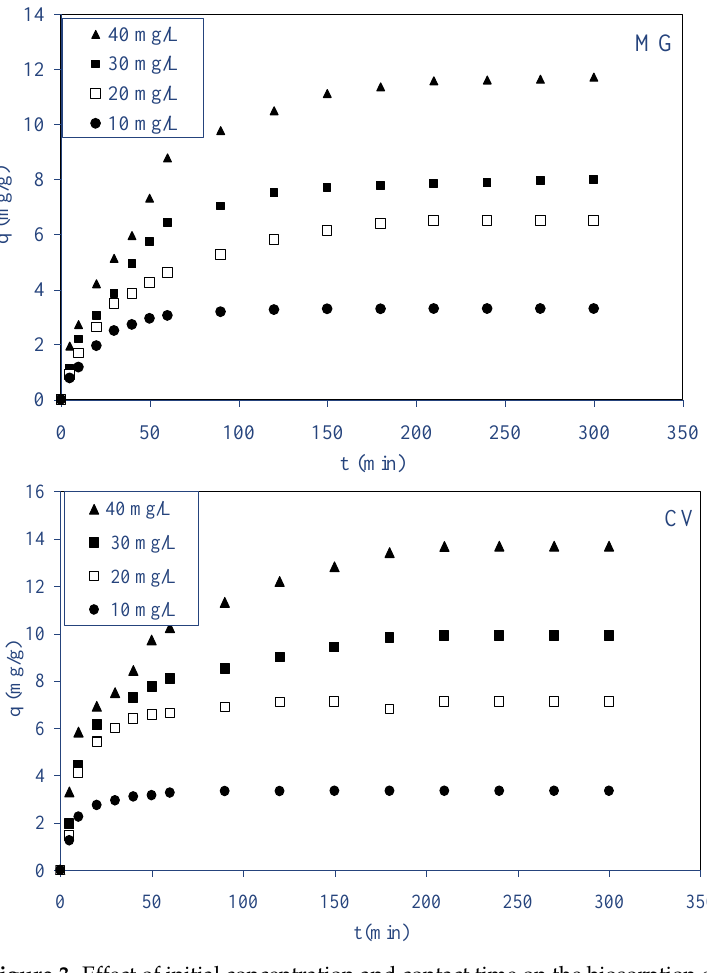
Figure 3. Effect of initial concentration and contact time on the biosorption of MG and CV dyes on ALP (C 0 : 10–40 mg/L; ALP dosage: 2.5 g/L; stirring speed: 400 rpm; pH (MG): 4, pH (CV): 6.5, T: 298 K).